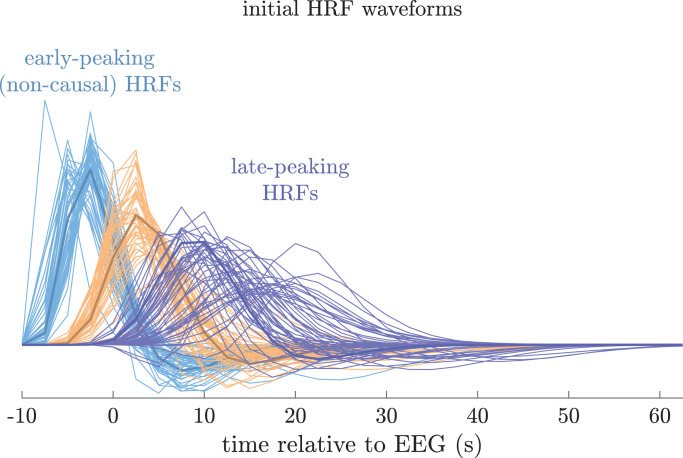
Different initializations of the HRF basis functions are used in every repetition of the sCMTF fitting procedure. In each repetition, one early-peaking, one mid-peaking and one late-peaking HRF were sampled from probability distributions of the HRF’s generating parameters (θ(1),θ(2) and θ(3), respectively) that was created by applying some multiplicative noise to baseline parameters (shown as the bold waveforms). The support extends to four negative samples, which gives the model the freedom to fit noncausal HRFs (relatively to the synchronized EEG).